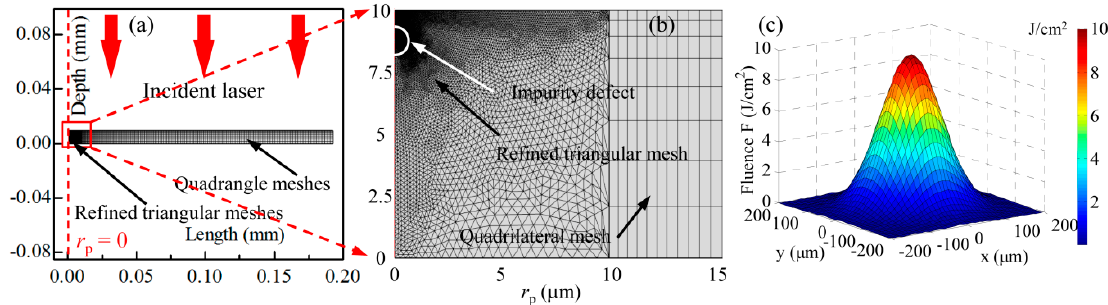
Figure 1. The finite element method (FEM) model for simulating the temperature and thermal stress distributions initiated by impurity defects under intense laser irradiation: ( a ) the FEM model; ( b ) the designed gridding; ( c ) the spatial energy distribution of applied Gaussian laser pulse.